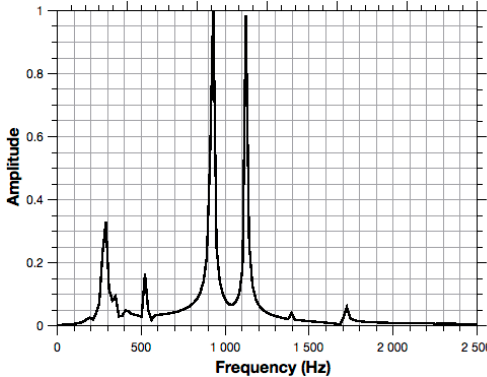
Figure 11. High-frequency oscillations. The scaling factor is equal to 10.6. The value of w = − Log against time at r > r 0 , r = 18.12 cm, r 0 = 2 cm, z 0 = 30.84 cm, z = 18.02 cm.